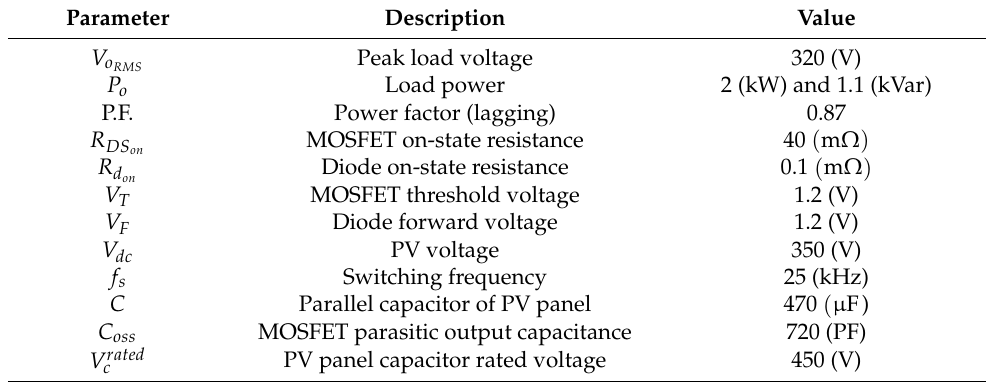
Table 4. Circuit Parameters for Simulation.